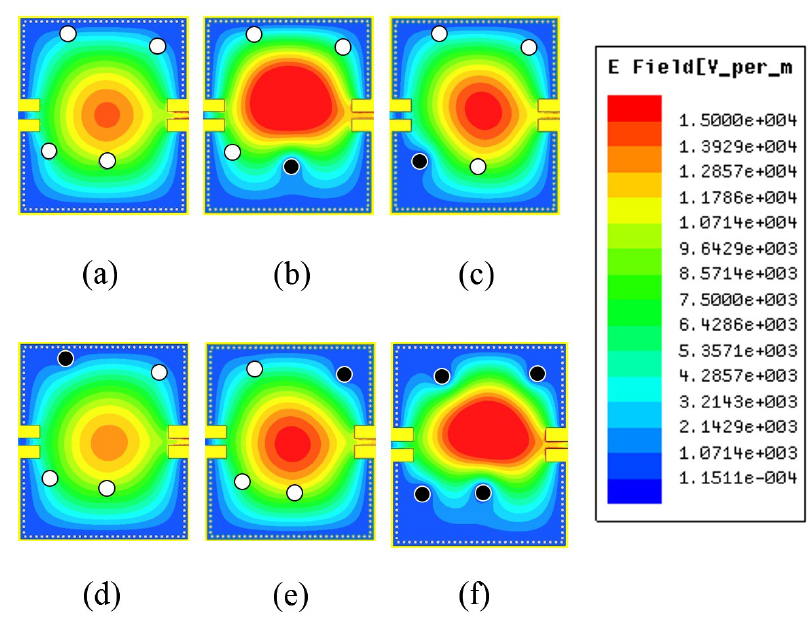
Figure 4. Magnitude of Electric Field Distributions at: ( a ) 0000; ( b ) 0001; ( c ) 0010; ( d ) 0100; ( e ) 1000 and ( f )